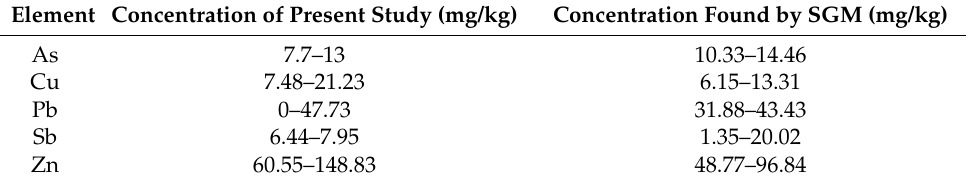
Table 4. Comparison of soil ranges, present study and SGM